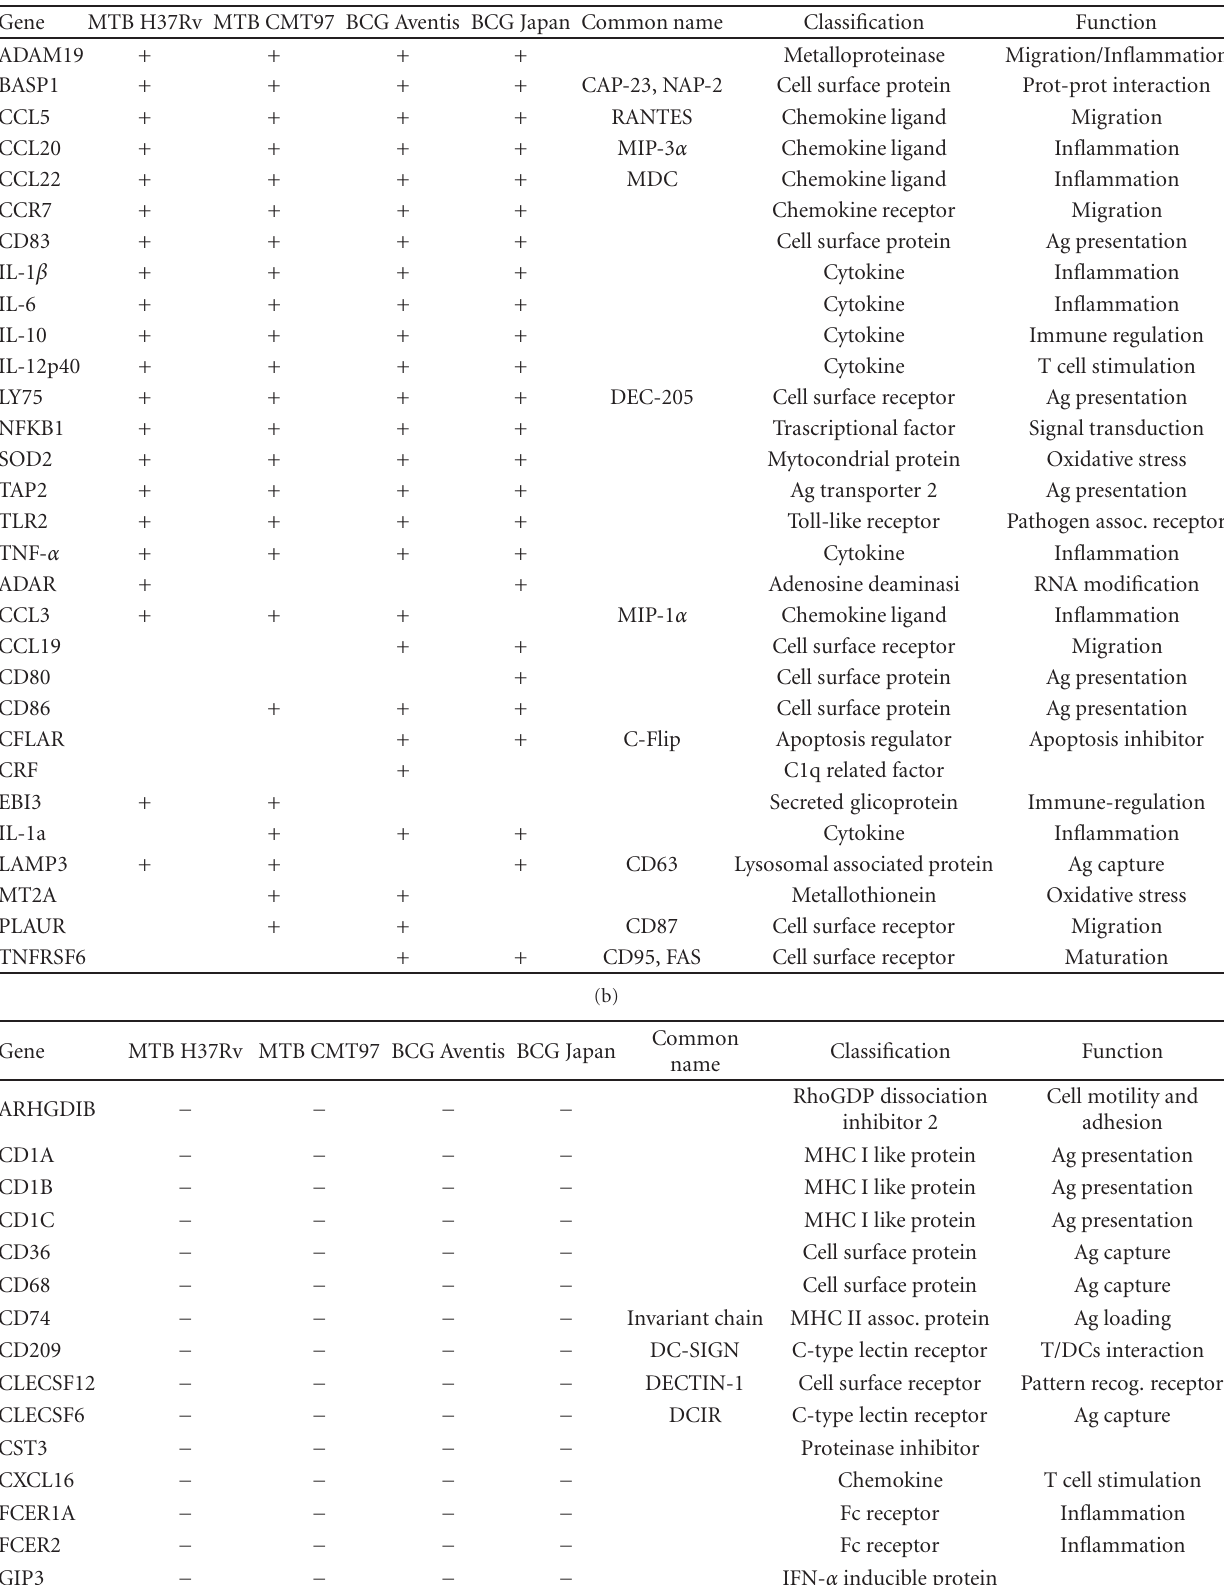
Table 2: (a) Upregulated genes of DCs infected with di ff erent MTB and BCG strains. (b) Downregulated genes of DCs infected with di ff erent MTB and BCG